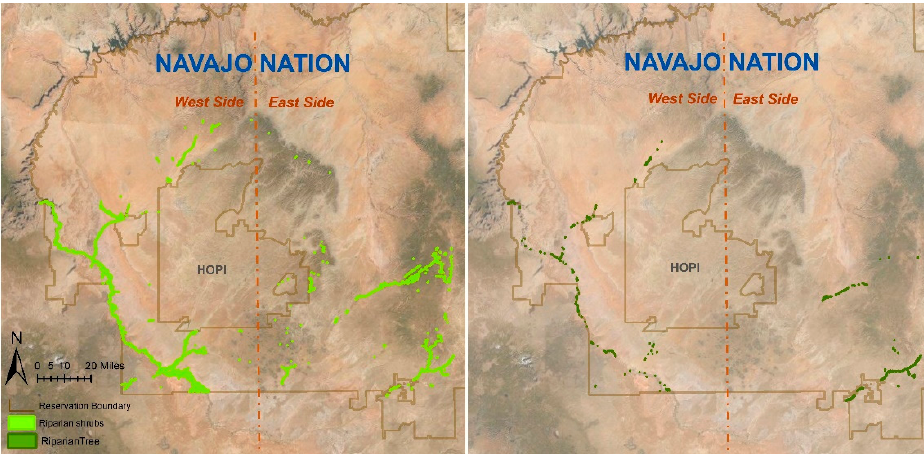
Figure 2. Digitized area showing riparian shrubs (left, light green) and trees (right, dark green) along select Little Colorado River tributaries and streams on the Navajo Nation that were delineated on a June 2019 high ‐ resolution (1 ‐ m) National Agricultural Imagery Program (NAIP) scene.